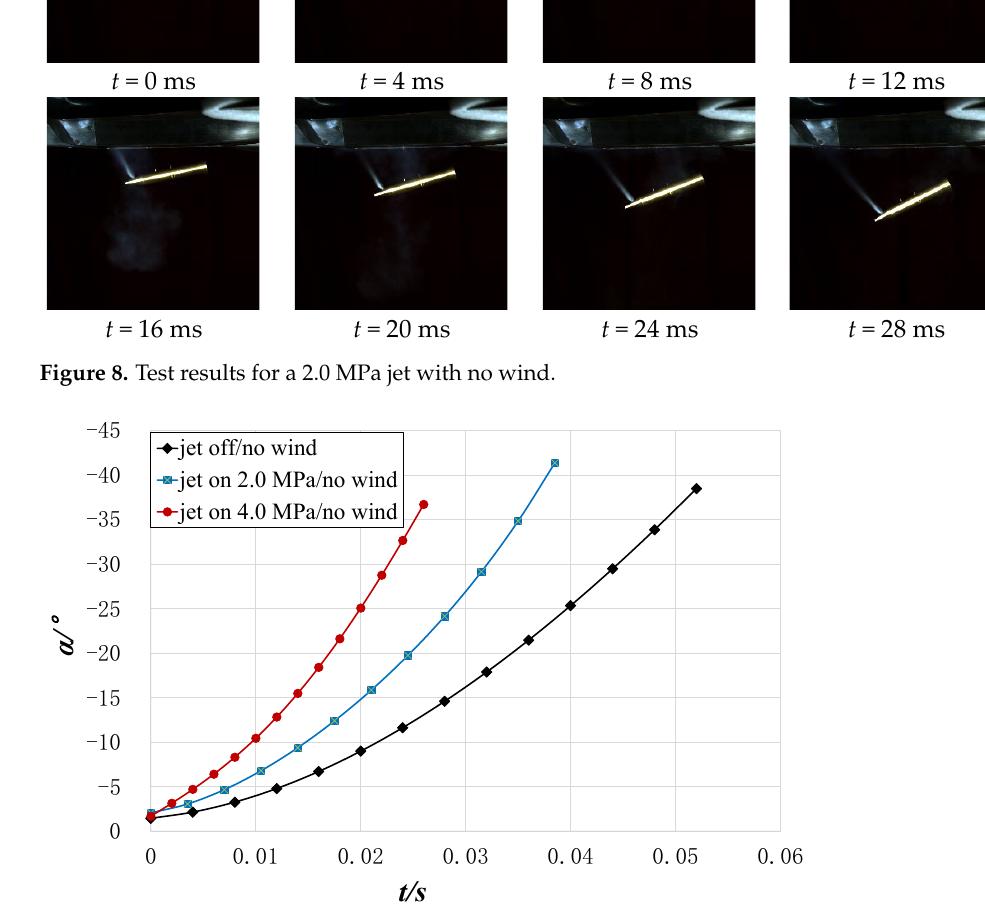
t = 28 ms Figure 10. Test results for a 4.0 MPa jet with no wind.